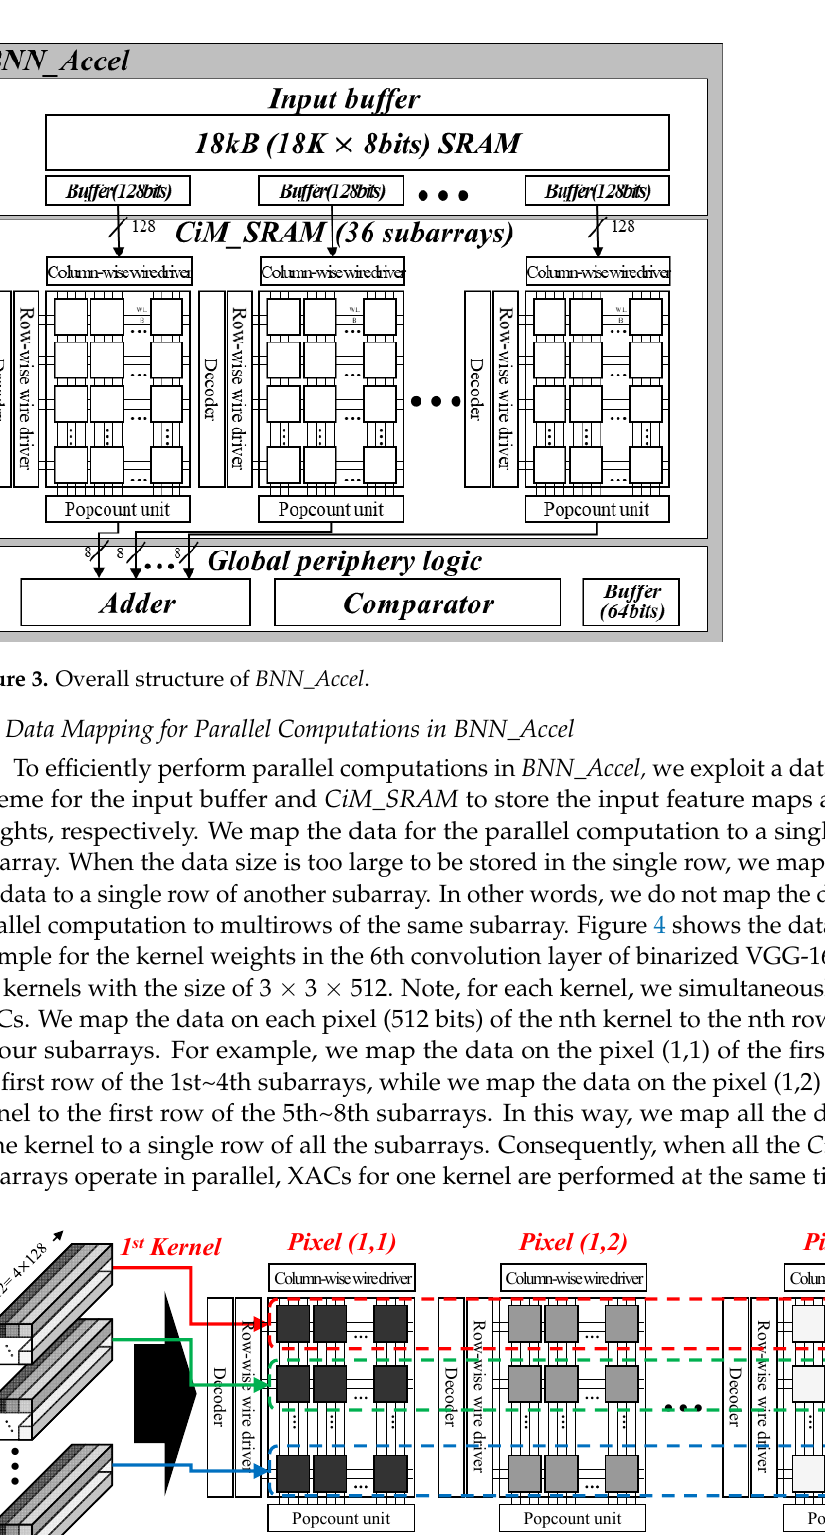
Figure 4. An example of data mapping scheme for parallel computations.